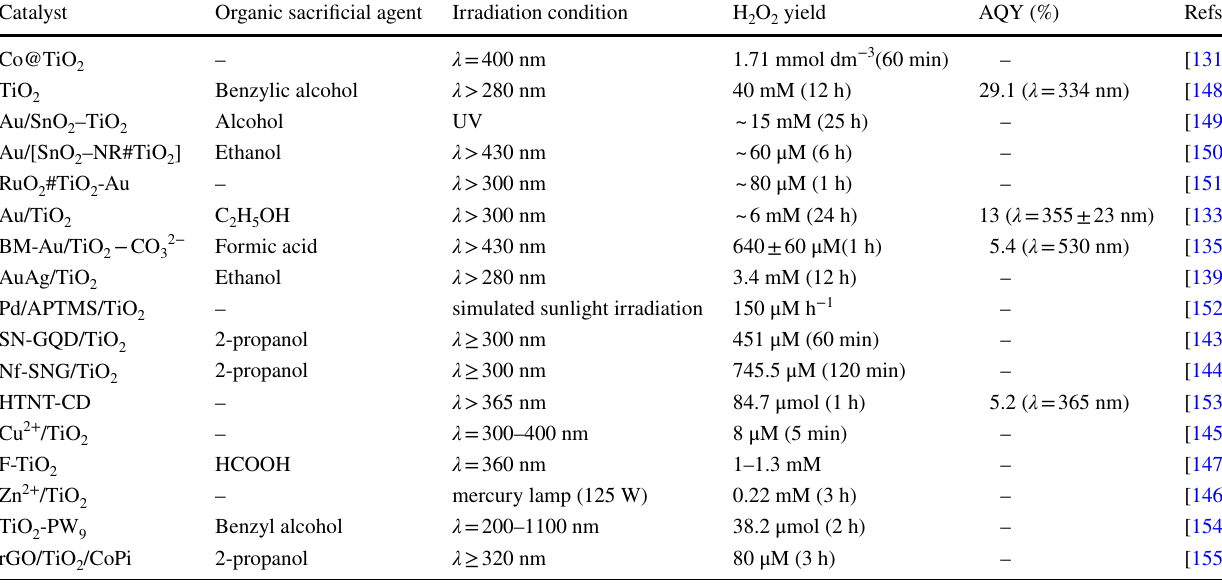
Table 2 Summary of TiO 2 photocatalysts for the H 2 O 2 production